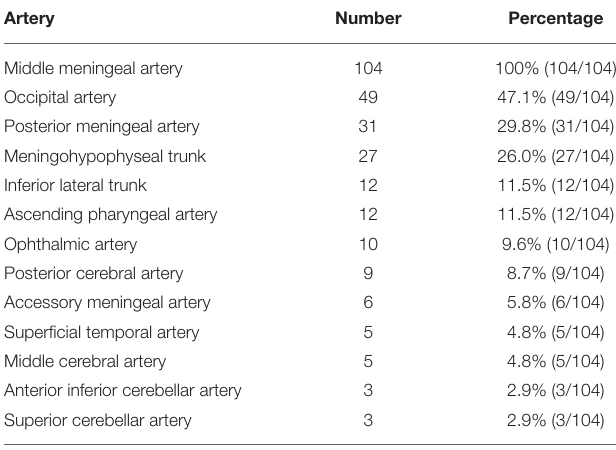
TABLE 2 | Distribution of feeding arteries of dural arteriovenous fistulas.